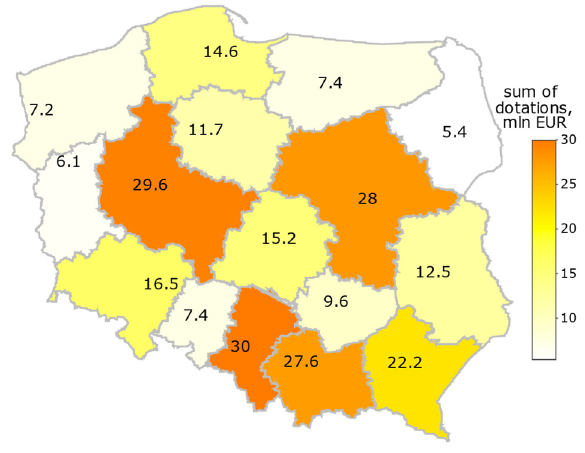
Figure 6. Total subsidies granted under the My Electricity Program. Source: own study based on [34].